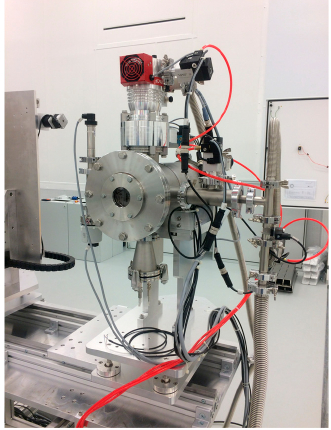
Figure 10. Picture of the FC installed along the in-air section of the ELIMAIA beamline.